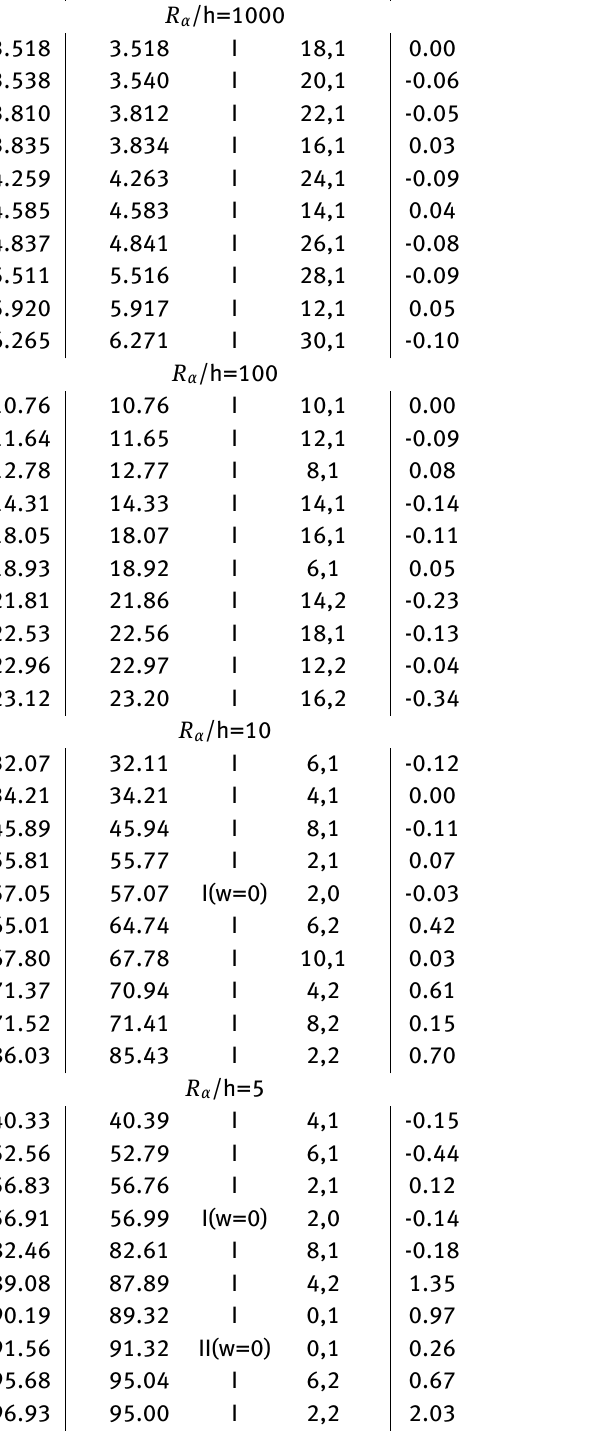
Table 12: Fifth benchmark, simply supported plate made of alu- minium alloy, titanium alloy and steel with thickness ratios a/h=1000, a/h=100, a/h=20 and a/h=10. First ten frequen- cies in Hz, comparison between the present 3D exact